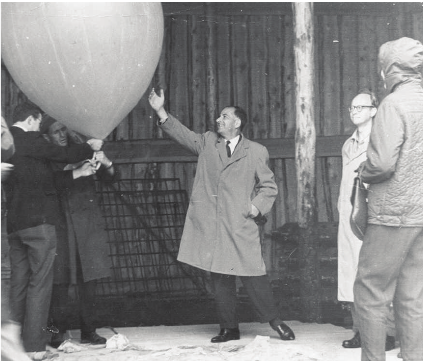
Figure 11: Academician B. M. Pontecorvo visiting the launch site of radiosondes in Apatity before one of the